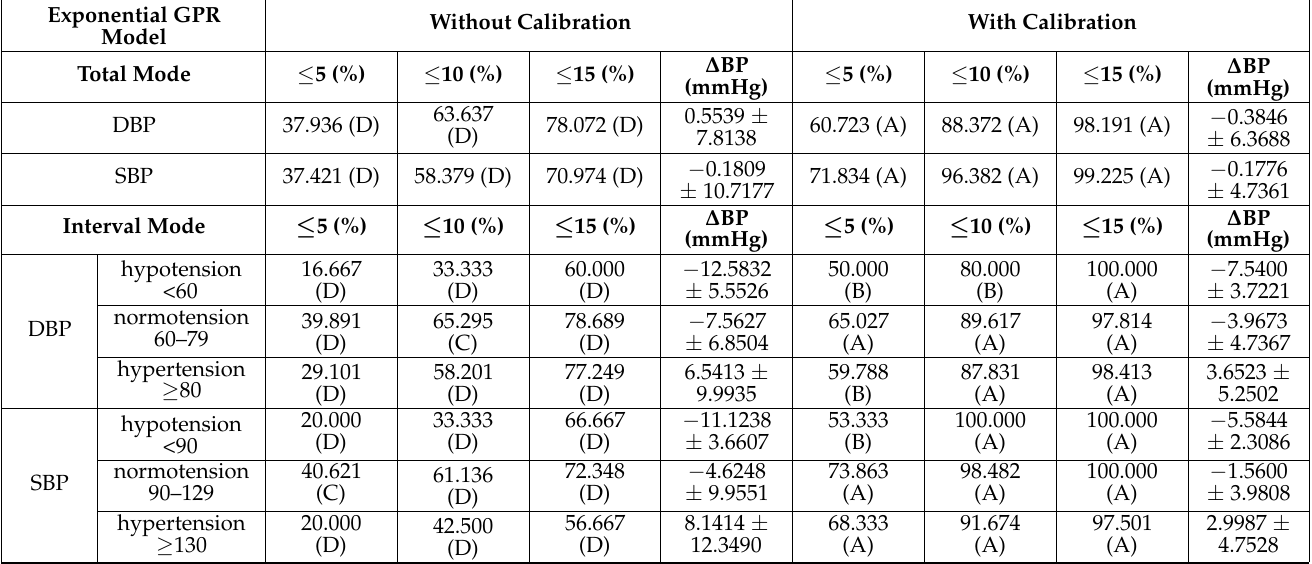
Table 4. Performance comparison of the BP estimation between without and with